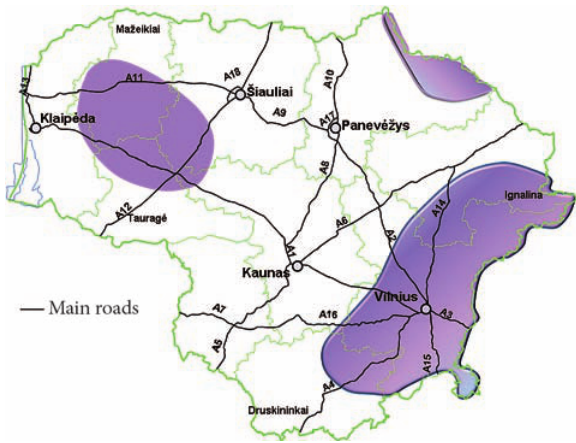
Fig. 4. General map of all climatic